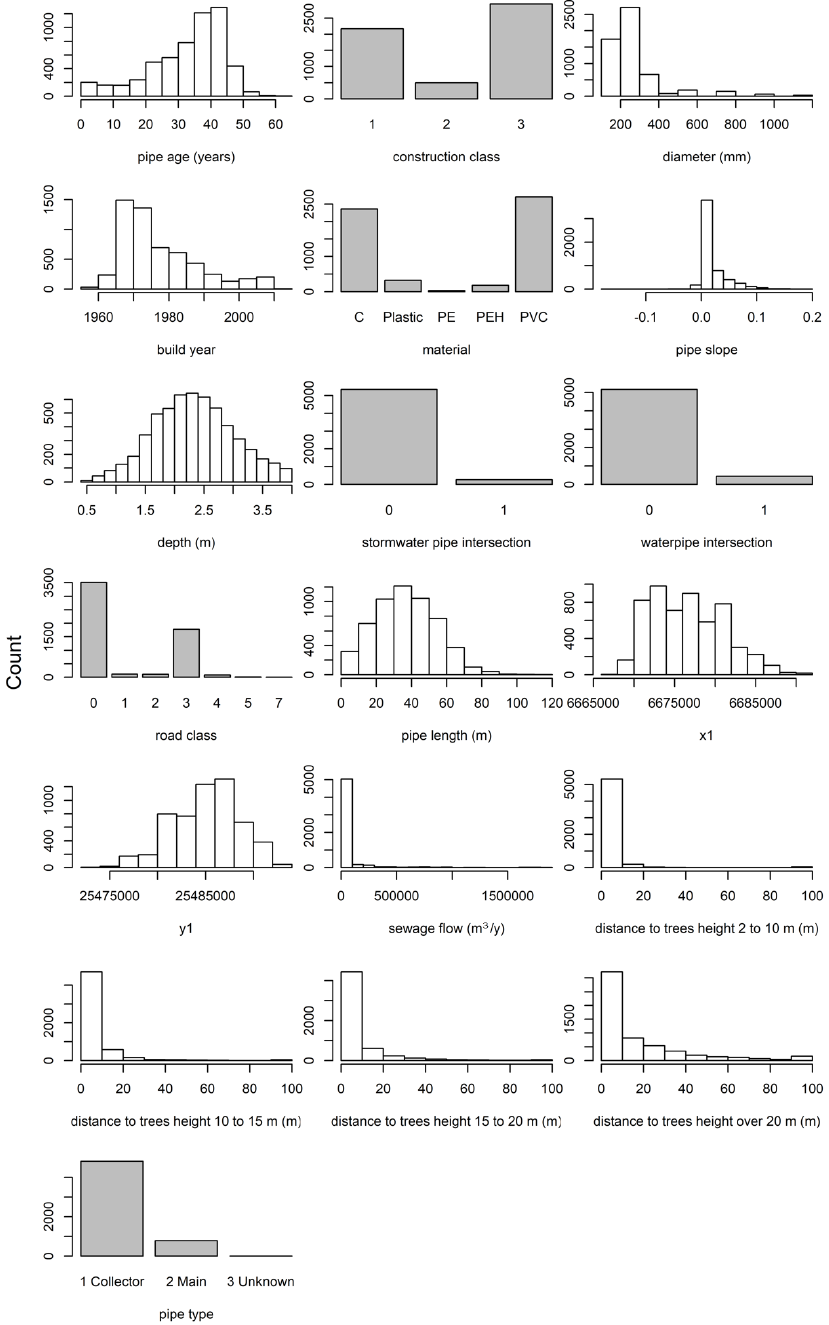
Figure 1. Histograms of the analysed data set. C: concrete; PE: polyethylene; PEH: polyethylene high-density; PVC: polyvinyl